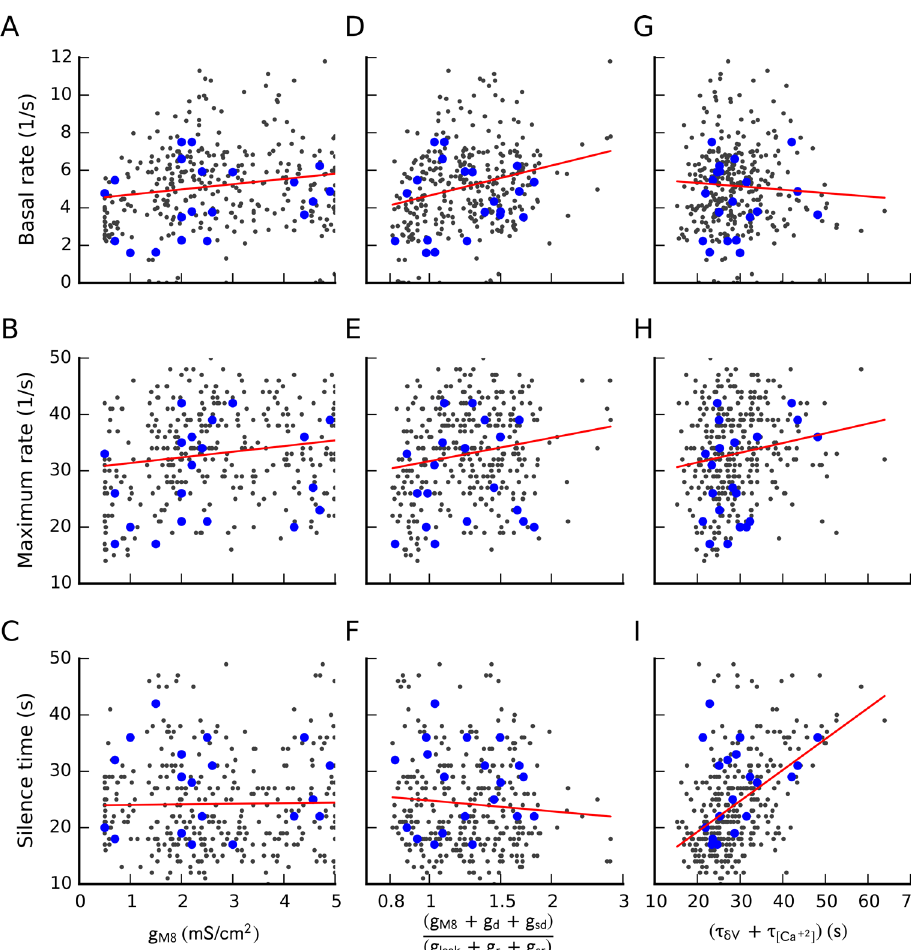
Fig 5. Relationship between some model parameters and the dynamic response. The basal firing rate at 33.5°C (A, D G), the maximum firing rate during the response to cold (B, E, H) and the seconds of silence after the cold pulse (C, F, I) are plotted against the TRPM8 conductance density (A-C), the ratio between depolarizing and repolarizing conductances (D-F) and the sum of the time constants involved in TRPM8 adaptation (G-I). Small black points represent the whole set of 360 parameter sets obtained and the large blue dots correspond to parameter sets listed in Table